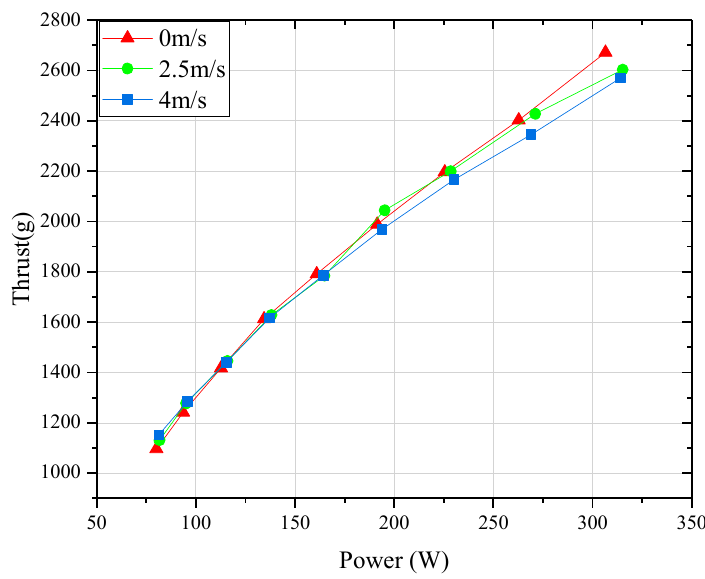
Figure 4. Thrust and power consumption with different wind speeds.